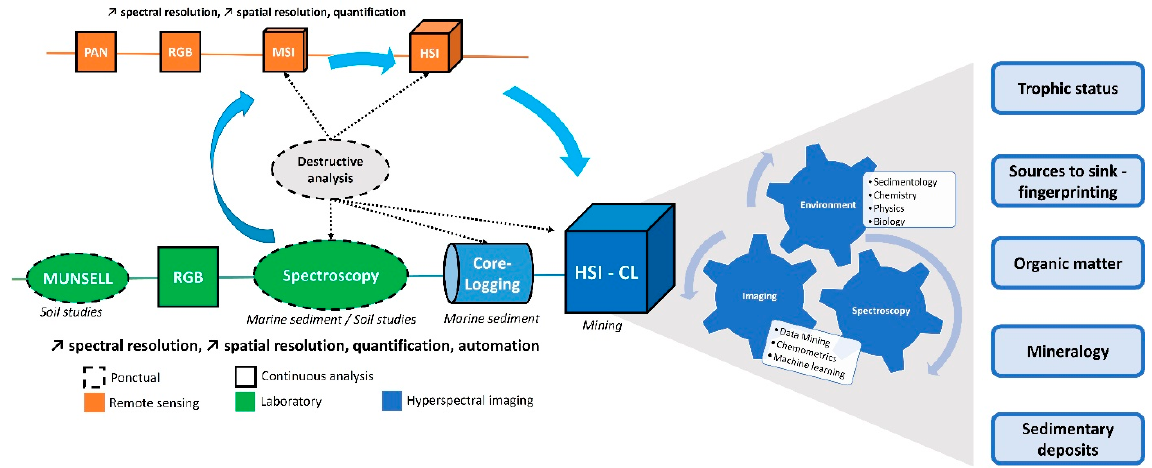
Figure 1. Schematic representation of the different techniques and domains involved in the development and exploitation of hyperspectral data for sediment core analysis (PAN: Panchromatic, MSI: MultiSpectral Image, HSI: HyperSpectral Image, CL: Core Logging) and some potential topics of study.